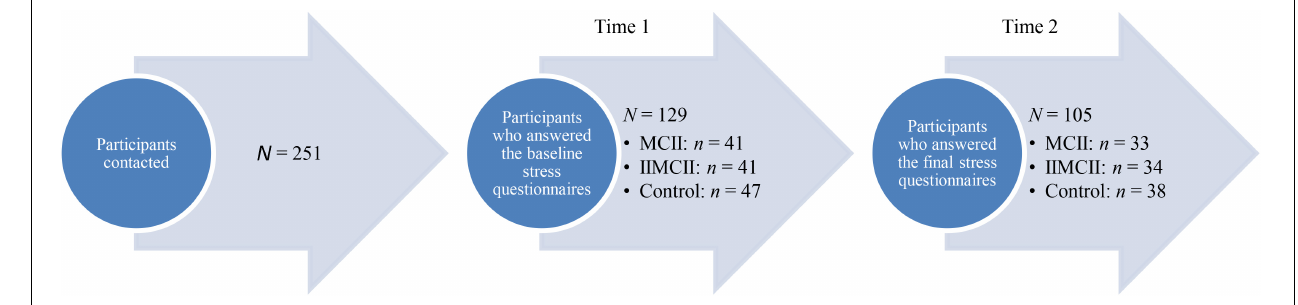
FIGURE 1 | Flowchart of the participants.